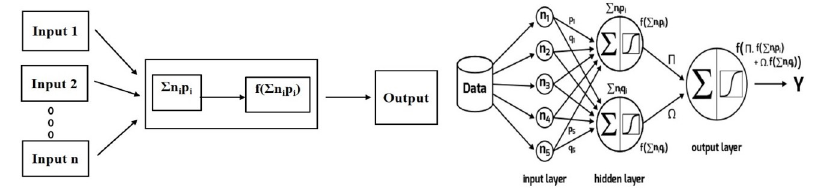
Fig 1. Architecture of artificial neural